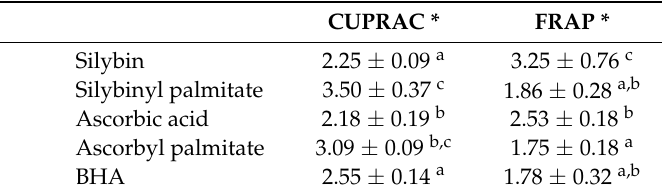
Table 2. Radical scavenging activity evaluation